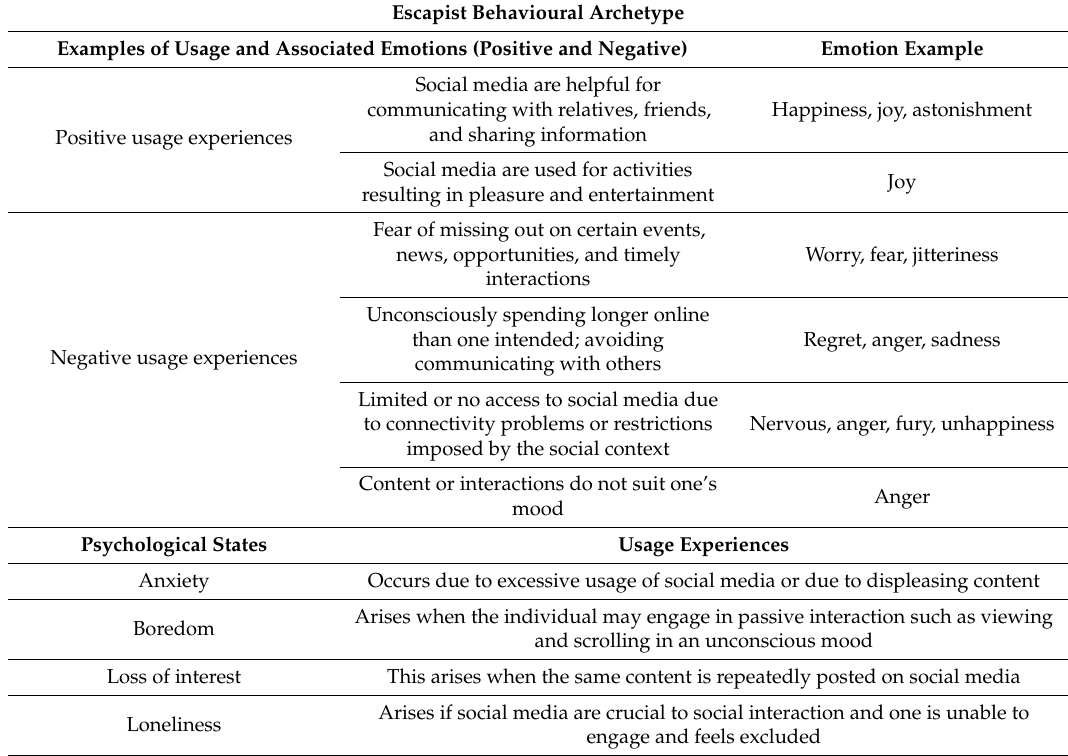
Escapist Behavioural